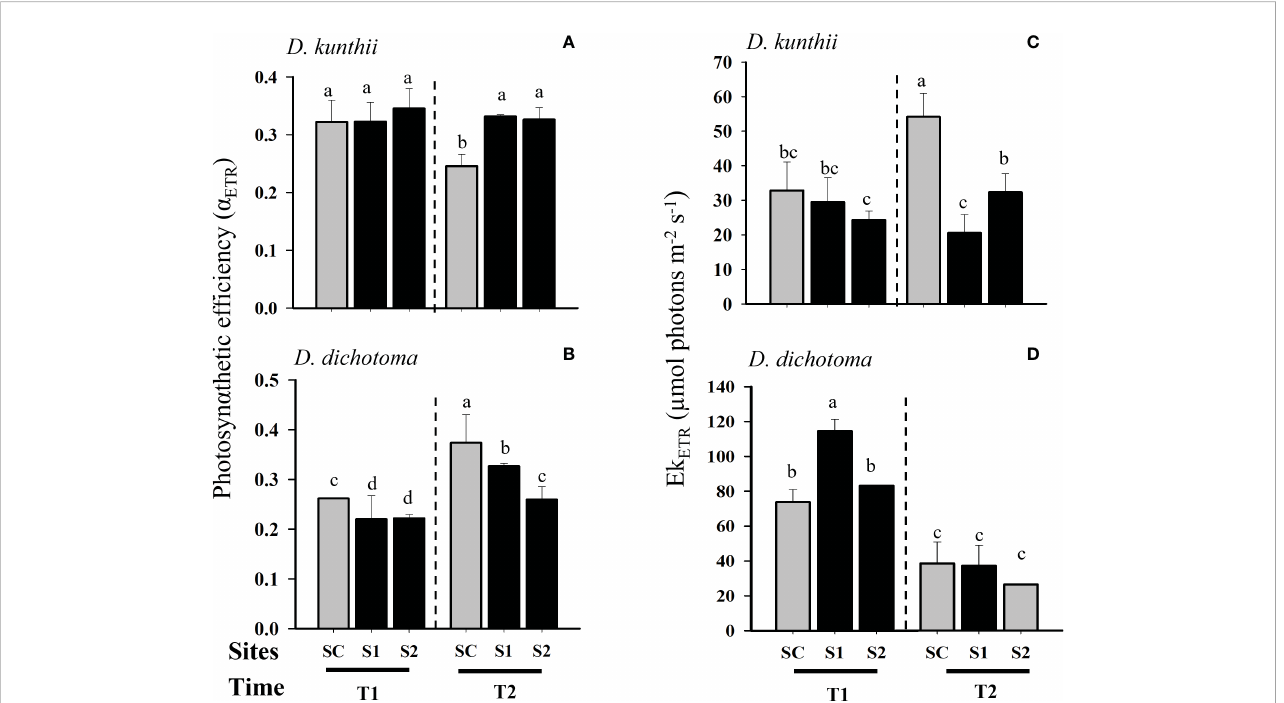
FIGURE 3 Photosynthetic responses as Photosynthetic ef fi ciency ( a ETR ) and Saturation of irradiance (Ek ETR ) in D. kunthii and D. dichotoma transplants under the in fl uence of brine discharge from a desalination plant. In D. kunthii , a ETR (A) and Ek ETR (C) were measured at 2 impacted sites with low (S1) and high (S2) in fl uence from brine discharge from a desalination plant located in Antofagasta, Chile, and using a control site (SC) at 3 (T1) and 7 (T2) days. In D. fl uence from brine discharge from a desalination plant dichotoma , a ETR (B) and Ek ETR (D) were measured in 2 impacted sites with low (S1) and high (S2) in located in Alicante, Spain, using a control site (SC) at 3 (T1) and 6 (T2) days. Data corresponds to mean ± SD ( n = 3). Letters represent statistical difference at 95% con fi dence interval (SNK test, p <